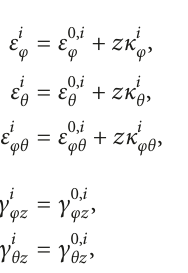
Figure 1: Geometry notations and coordinate system of spherical shell.